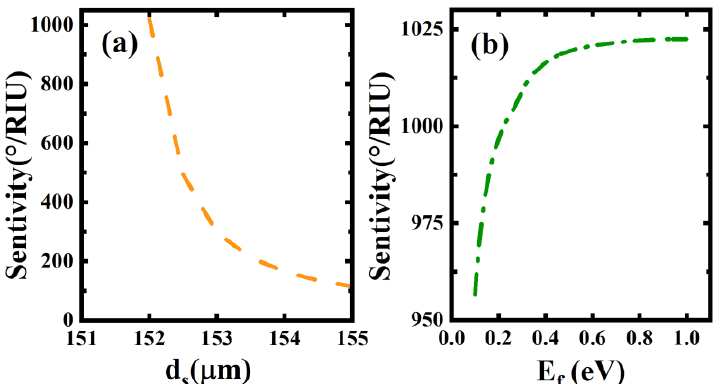
Figure 4. The variation of the sensitivity of the biosensor on ( a ) the thickness of the sensing layer; ( b ) the BDS Fermi energy. Other parameters are the same as in Figure 2.